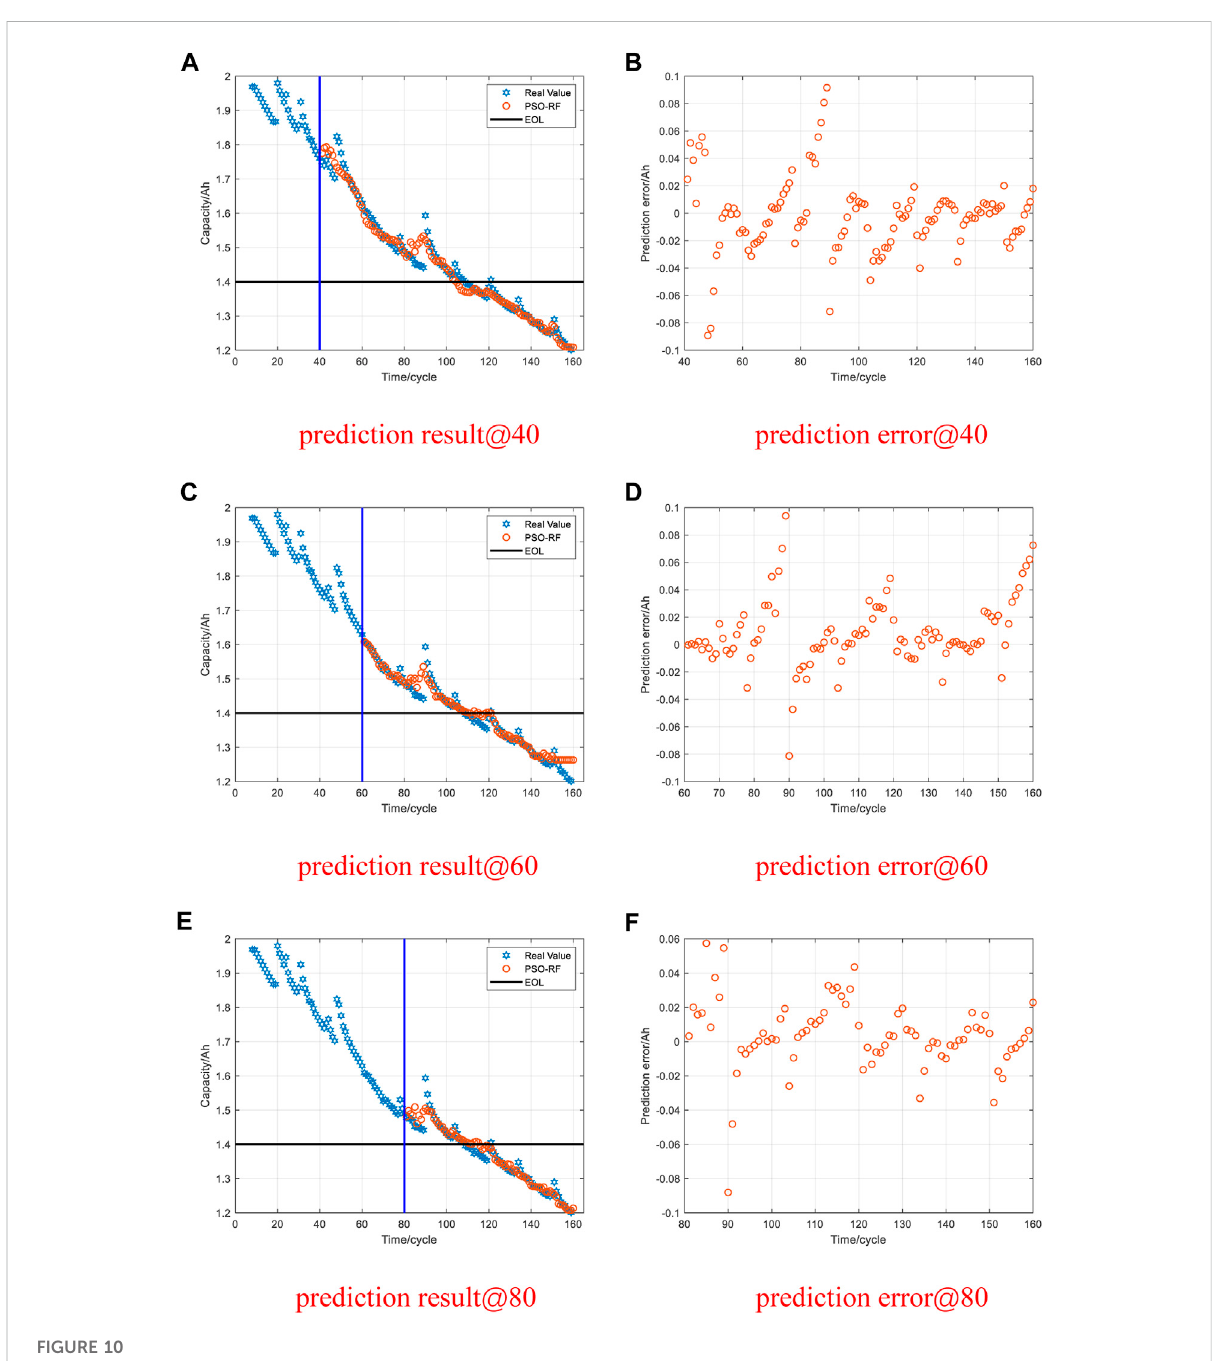
FIGURE 10 Results and errors of B0006